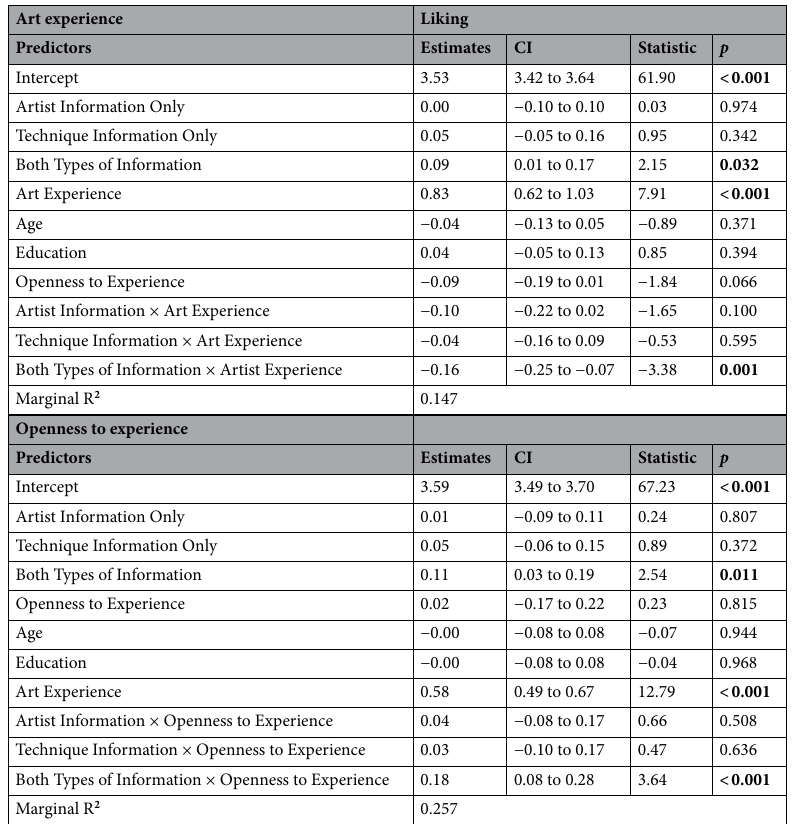
Table 2. Beta values, confidence intervals, p-values for art_experience and openness_experience model for liking ratings. Significant values are in